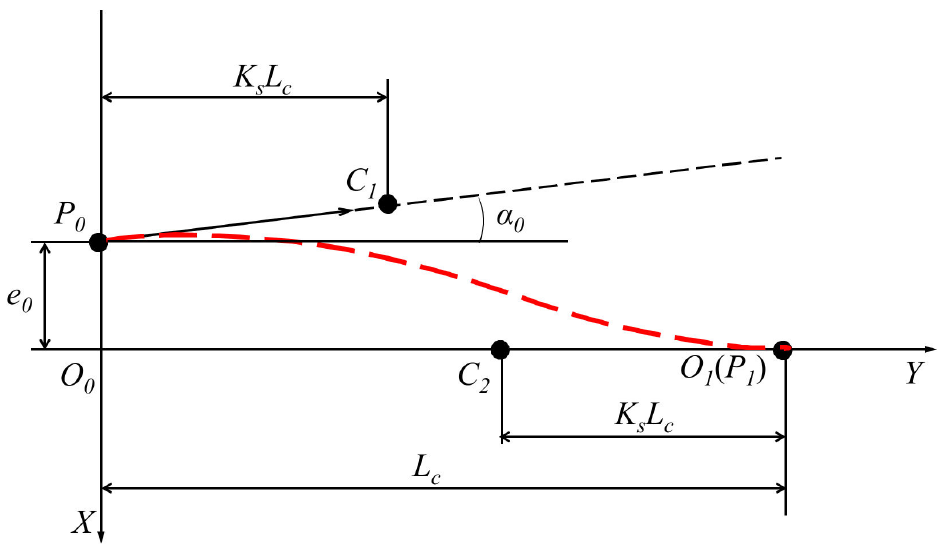
Figure 8. Planning path of third-order Bessel curve when | e 1 | > | e 0 | and | e 0 | ≤ [ e